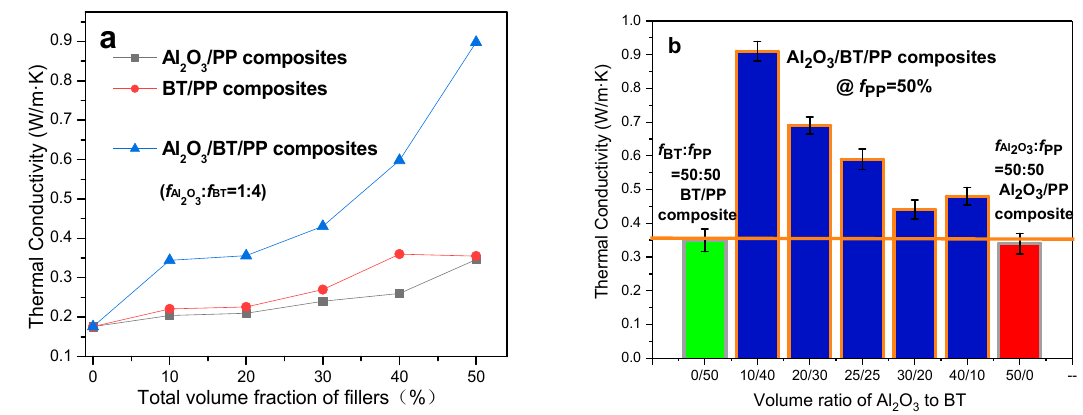
Figure 1. Thermal conductivity of the composites: ( a ) Al 2 O 3 /PP, BT/PP and Al 2 O 3 /BT/PP composites; ( b ) Al 2 O 3 /BT/PP composites.